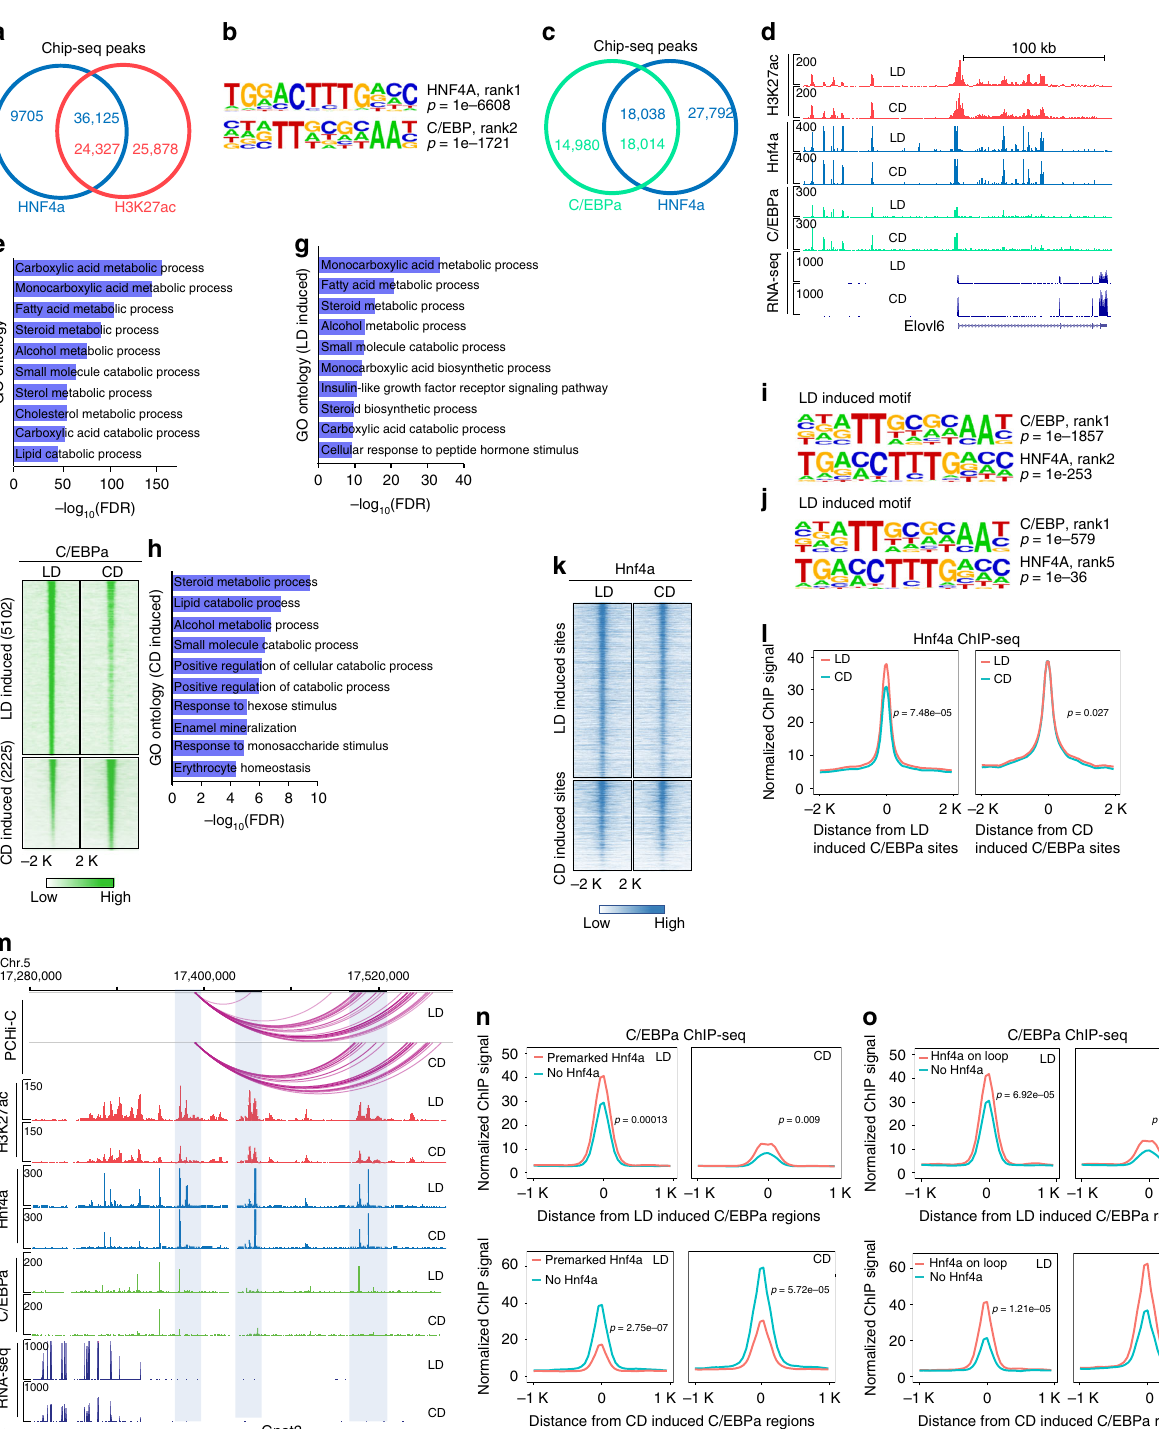
Fig. 7 Hnf4 α frequently co-binds with C/EBP α . a Overlap between Hnf4 α and H3K27ac sites, regardless of diet conditions. b Motifs enriched in overlapping regions of Hnf4 α and H3K27ac. c Overlap between Hnf4 α and C/EBP α binding sites, regardless of diet. d The genome browser shot provides an example of colocalization of Hnf4 α and C/EBP α binding at the Elovl6 locus. e GO analysis of Hnf4 α and C/EBP α overlapping regions. f Heatmap of C/EBP α signal at diet-induced differentially bound regions. g , h GO analysis of C/EBP α differentially bound regions. i , j Motifs enriched at C/EBP α differentially bound regions. k Heatmap of Hnf4 α and H3K27ac signal at C/EBP α differentially bound regions. l Metagene plot of Hnf4 α signal at C/EBP α differentially bound regions. m Example of Hnf4 α binding at a promoter interaction site as a bookmark for C/EBP α . n Metagene plot of C/EBP α at differentially bound regions with or without premarked Hnf4 α . o Metagene plot of C/EBP α at differentially bound regions with or without premarked Hnf4 α at promoter interactions. Signi fi cance (Mann – Whitney U test) is indicated in the fi